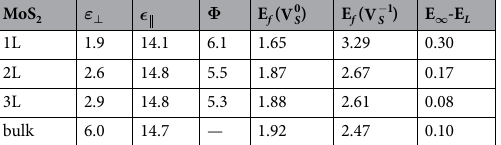
planes is found to be 6.21 Å. Overall, structural, dielectric, and electronic properties computed in this study are in agreement with recent DFT study of the MoS 2 systems 16 . To calculate formation energies, we use half the energy of molecular S 2 and a Fermi level equal to the valence-band edge as chemical potentials for S and electrons, respectively. Relevant DFT results are reported in Table 2. With the parameters in Table 1, our polarizable energy scheme gives, in agreement with our DFT calculations (Table 2), an in-plane and out-of-plane dielectric constant of 14.1 and 2.0, respectively, for monolayer MoS 2 , and values of 14.5 and 2.2 for bilayer MoS 2 , 14.7 and 2.5 for the tri-layer film, and 15.0 and 6.6 for the bulk phase. This polarizable energy scheme and atomistic model structures of the MoS 2 systems are thus used to estimate the energy corrections for the formation energies of the charged S vacancy defect obtained by DFT (Table 2). In these calculations, the defect is described by using a negative unit charge in the center of a triangular interstice formed by nearest neighboring Mo ions. Point- or Gaussian-like (with a width of 1 Å) distributions for the unit charge yield results differing by only 0.02 eV. Figure 5 shows the results obtained in the case of monolayer MoS 2 ; similar energy vs. 1/ L curves are obtained also in the case of bilayer and trilayer MoS 2 . The correction energies obtained by extrapolation of the energy values to infinite volumes are shown in Table 2. It has to be noted that due to the low dimensionality of the material, the defect energy in Fig. 5 scales non-trivially with L − 1 . In the present case, we find that extrapolation of the energy values to large volumes is aided